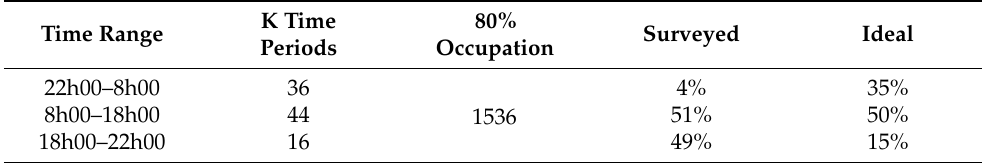
Table 6. Scenario with 80% occupation of the charging